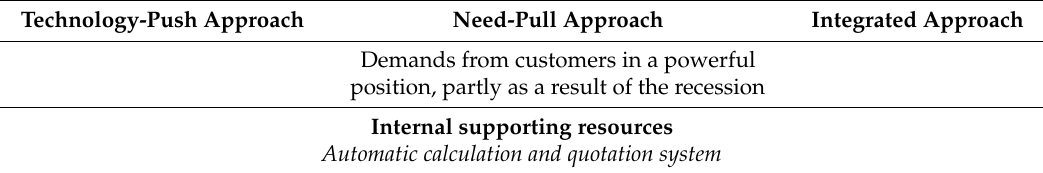
Table 5. Summary of the adoption drivers for De